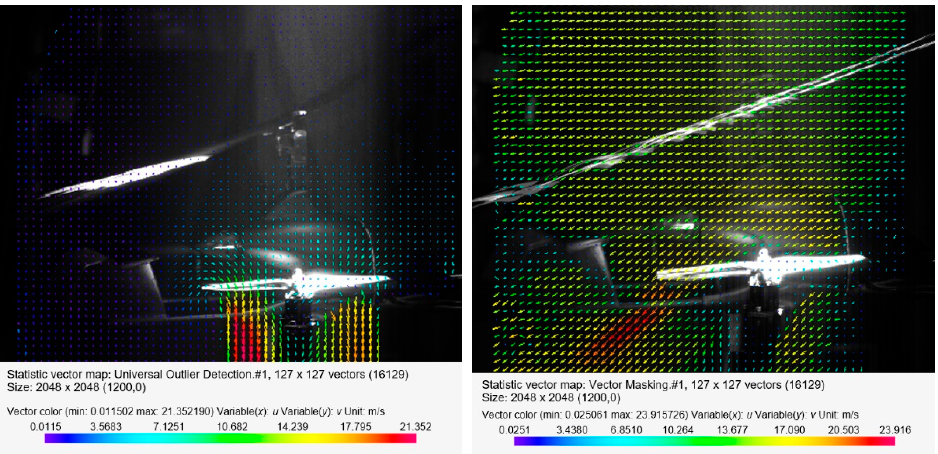
Figure 13. Velocity field around the horizontal propeller for the following configuration: angle of attack α = 0 ◦ , without airflow (on the left) and with airflow v